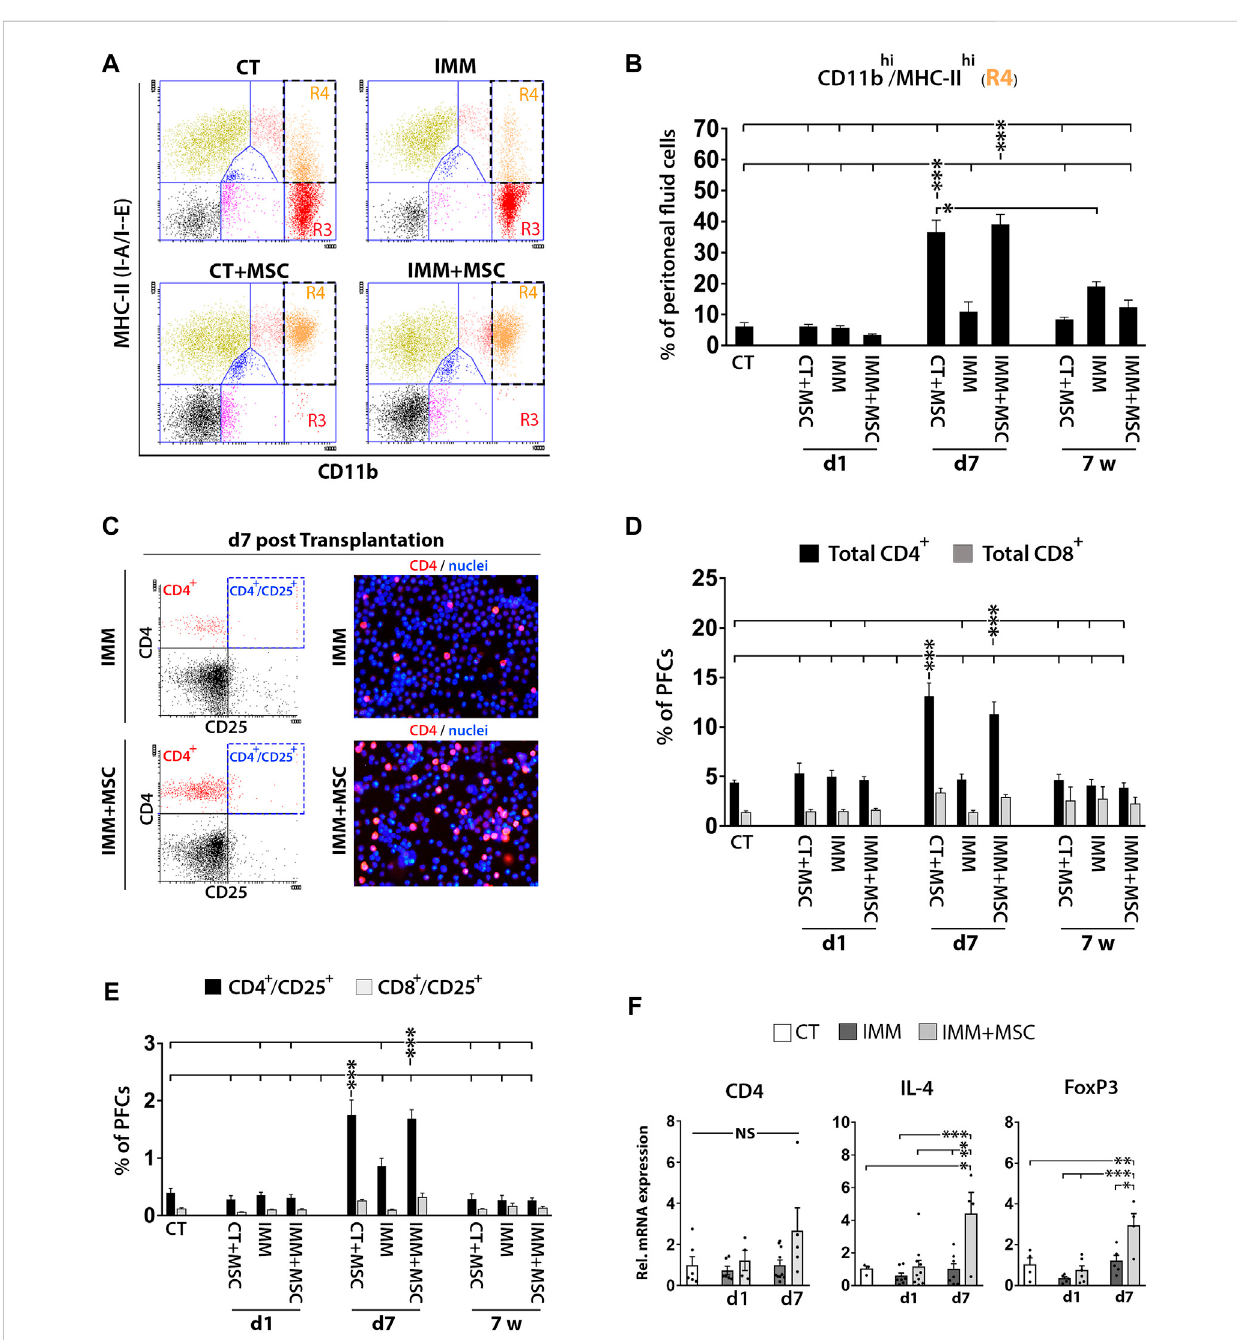
UC-MSC transplantation induces in a second step a strong activation of peritoneal macrophages and mobilization of T Cells and regulatory T Cells. (A, B) Peritoneal macrophages are massively activated at 7 days post-transplantation, but return to a lower activation state after 7 weeks post- transplantation. (A) Representative CD11b and MHC-II expression dot plots of PFC from 7 days transplanted CT or IMM RIP-B7.1 mice with vehicle or 5 × 10 5 UC-MSC. Note how CD11b hi /MHC-II neg-low peritoneal macrophages (R3 region) in CT and IMM mice shifted to an activated CD11b hi /MHC-II hi phenotype (R4 region) in CT + MSC and IMM + MSC mice. (B) Quanti fi cation of CD11b hi /MHC-II hi activated macrophages percentages within PFC. (C – F) Peritoneal fl uid contains increased T Cells and activated T Cells percentages and regulatory T Cells markers at 7 days post-transplantation. (C) Representative CD4 and CD25 expression dot plots and CD4-PE stainings of PFC from IMM and IMM + MSC mice at 7 days post-transplantation. (D) Quanti fi cation of total CD4 + and CD8 + T Cells percentages within PFC. (E) Flow cytometric quanti fi cation of CD4 + /CD25 + and CD8 + /CD25 + activated T Cells percentages within PFC. (B, D, E) PFC were collected from CT and IMM RIP-B7.1 mice, at 24 h, 7 days and 7 weeks post-transplantation with vehicle or 5 × 10 5 UC-MSC. (F) Q-PCR analysis of CD4, interleukin-4 (IL-4) and forkhead box P3 (FoxP3) mRNA expression in PFC collected from CT and immunized RIP-B7.1 mice transplanted with vehicle (IMM) or 5 × 10 5 UC-MSC (IMM + MSC) at day 1 and 7 post-transplantation. Results show relative mRNAexpressiontoCTmice(valuesetas1). (B,D,EF) Valuesaremean±s.e.mofn ≥ 5miceforeachexperimentalgroup.*, p ≤ 0.05;**, p ≤ 0.03;***, p ≤ 0.01, one-way ANOVA. NS is for not signi fi cant